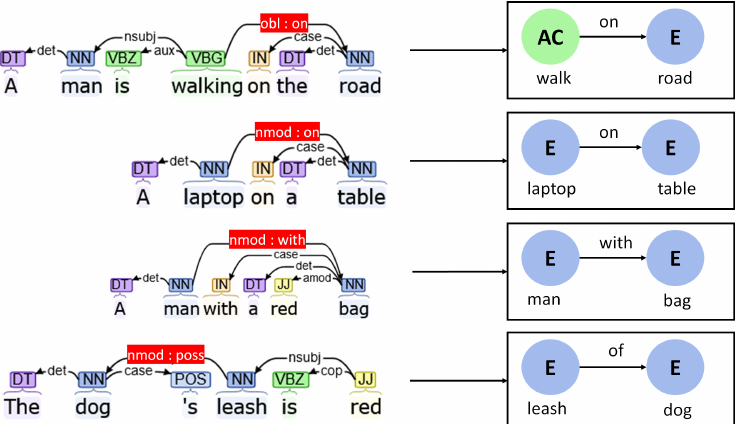
Figure 9. Deriving edges signifying spatial relations from dependencies.